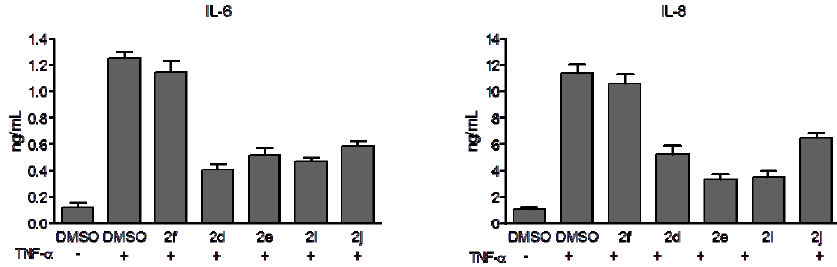
Figure 4. Effects of BBR analogues on TNF - α -induced cytokine of interleukin (IL)-6 and IL-8.